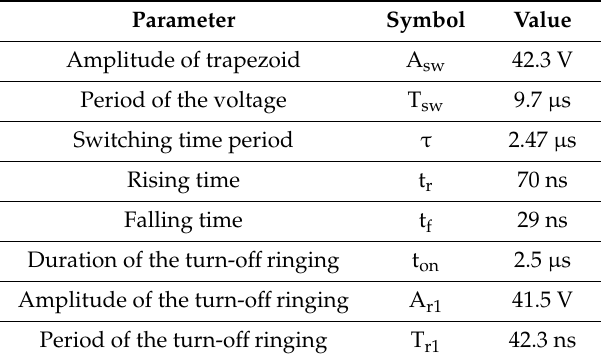
Table 2. Characteristic parameters of the switch voltage